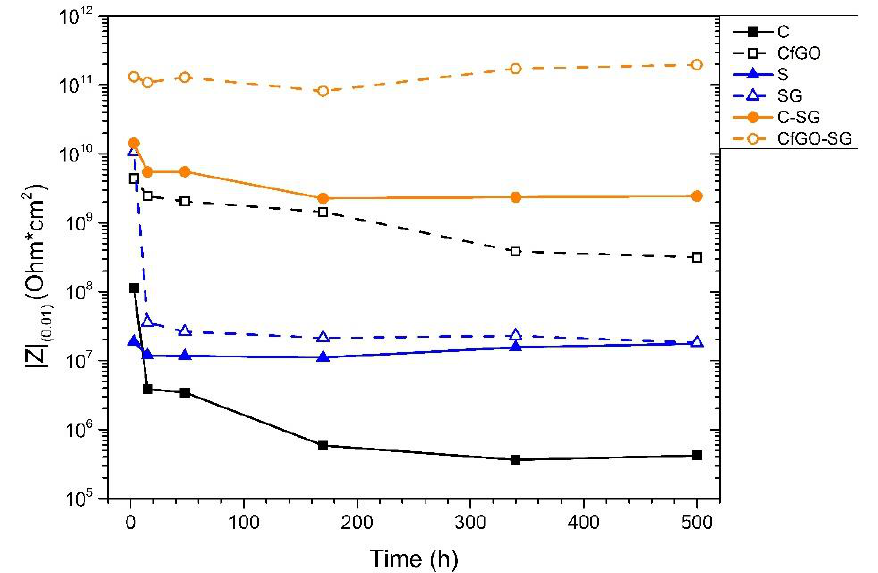
Figure 10. Bode impedance modulus |Z| (0.01) evolution with time.